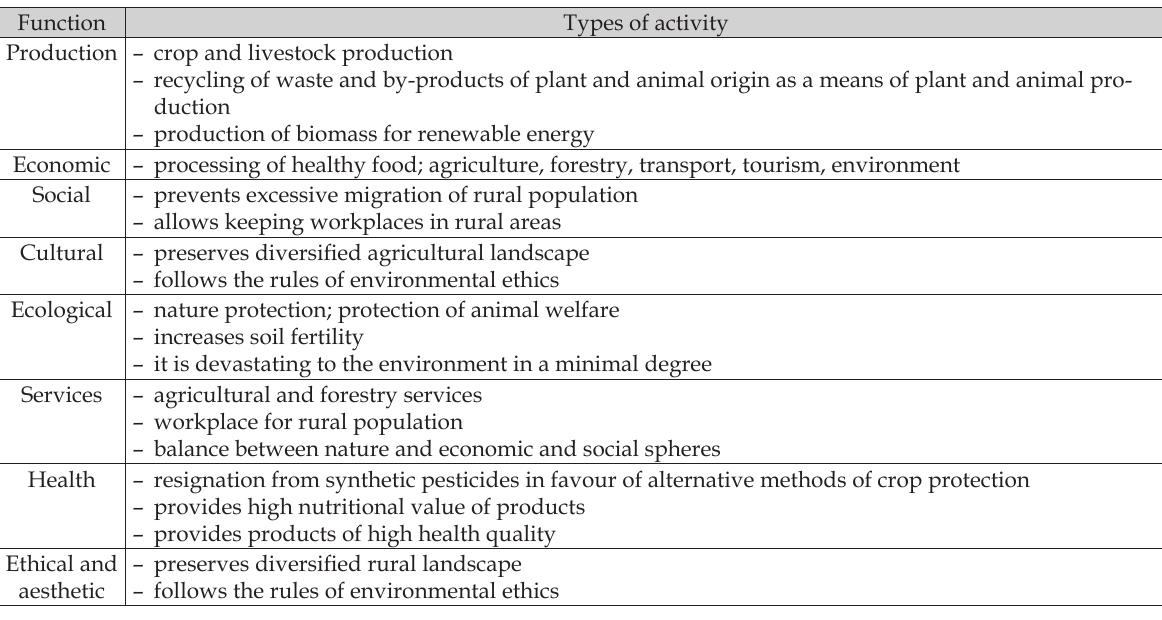
Table 1. Advantages of organic